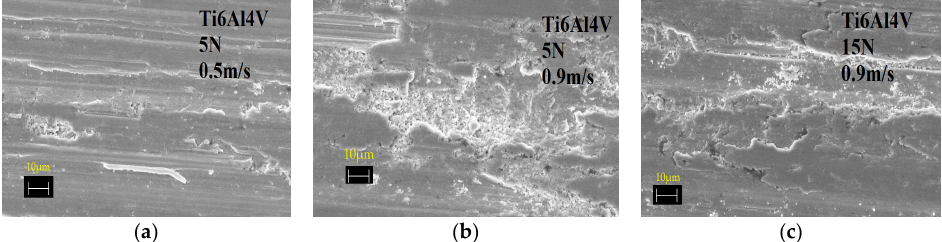
Figure 13. Scanning electron microscope image of the uncoated Ti alloy in the wear zone. ( a ) 5 N and 0.5 m/s, ( b ) 5 N and 0.9 m/s, ( c ) 15 N and 0.9 m/s. The increase in load and sliding rate increases the wear mass loss, as seen in Figure 13b,c. The increase in sliding rate produces debris, which deforms the surface texture and increases the wear track width. The deformed surface accelerates wear in dry sliding wear, grooving and spallation wear mechanism [56,57].